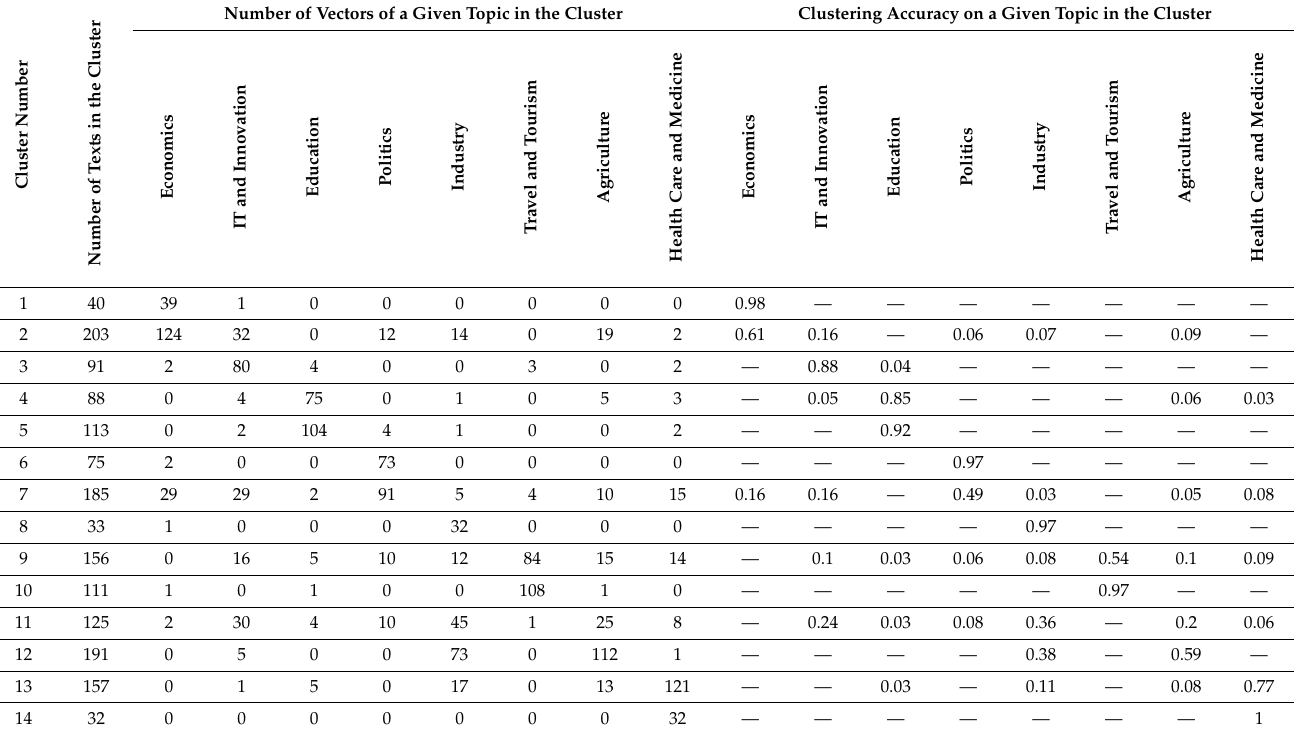
Table 1. Results of clustering the studied text corpus and its accuracy assessment based on the use of semantic characteristics for their vector